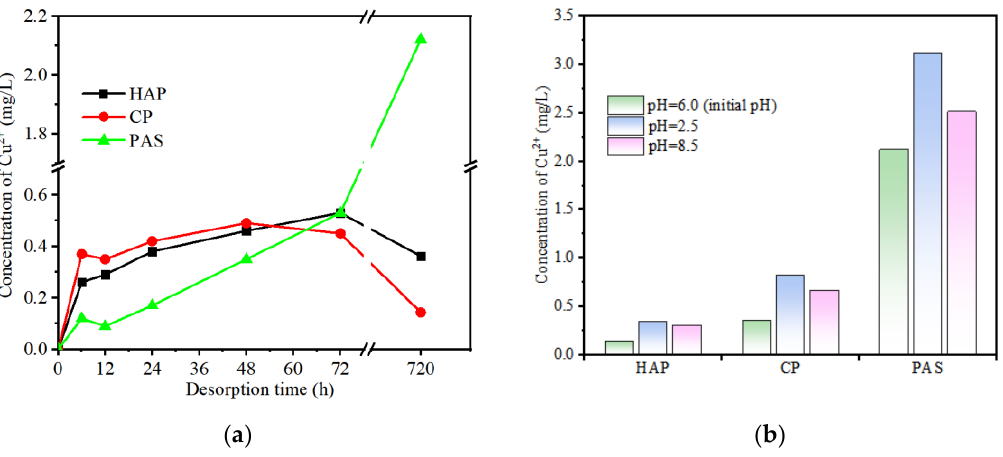
Figure 5. Influence of desorption time ( a ) and pH ( b ) on stability of